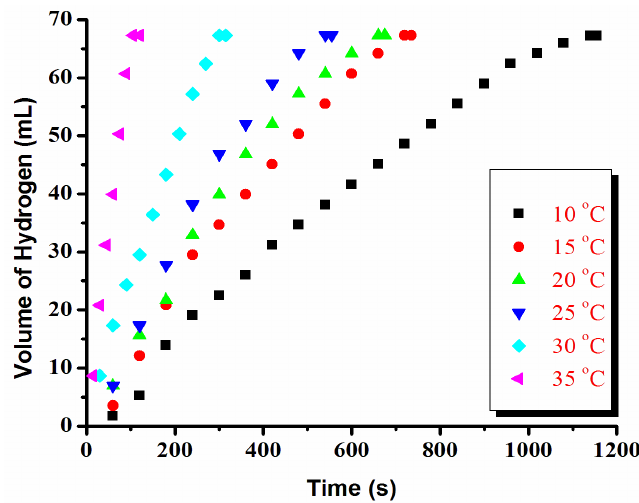
Figure 3. Volume of hydrogen versus time graph for the dihydrogen phosphate anion stabilized ruthenium(0) NP-catalyzed hydrolysis of AB at different temperatures ([Ru] = 0.50 mM, [AB] = 100 mM).